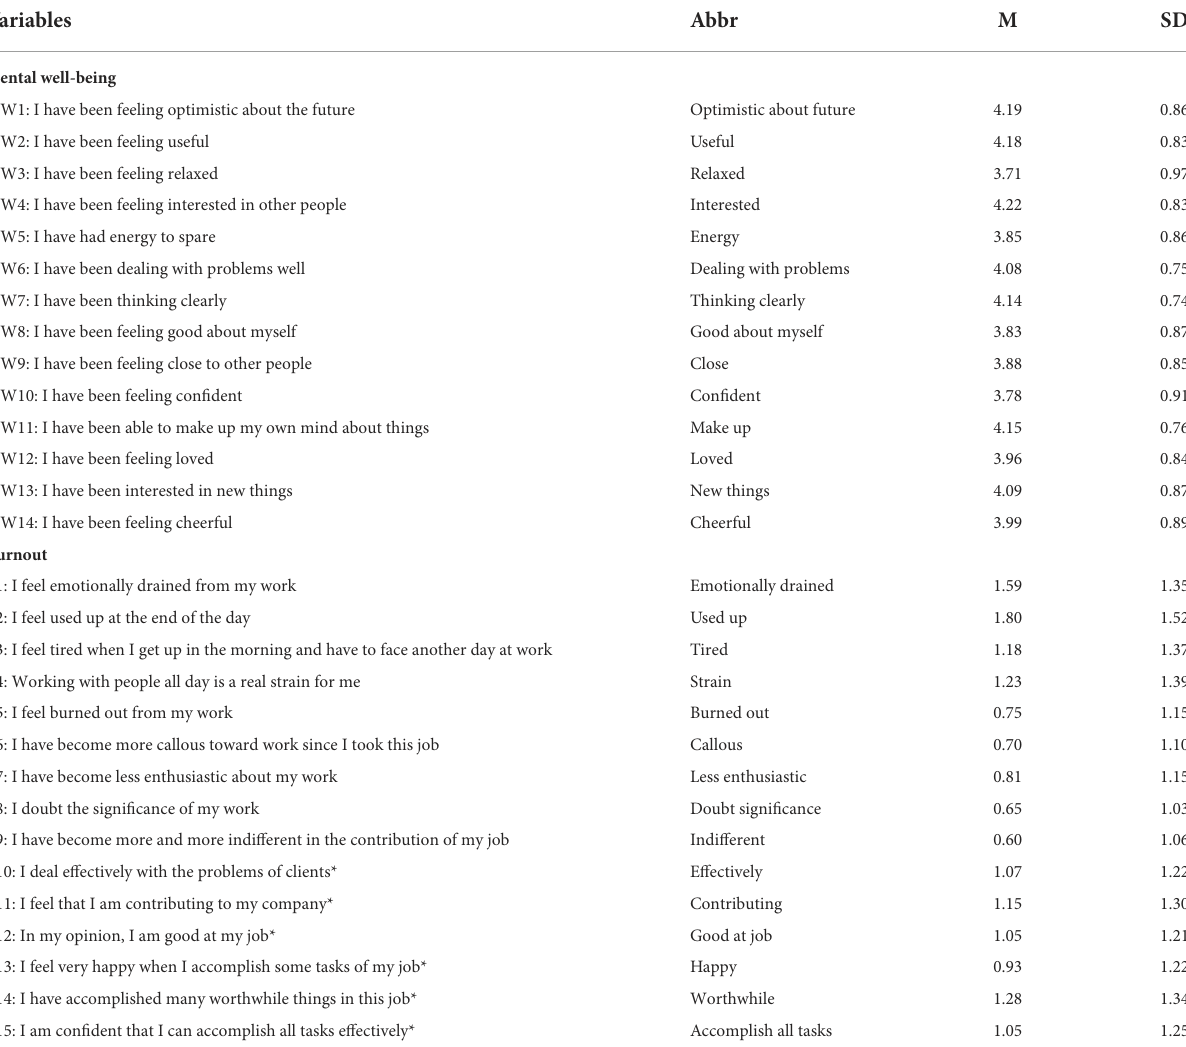
TABLE 2 Abbreviation, mean scores, and standard deviations for each variable selected in the current network. Variables Abbr M SD Mental well-being